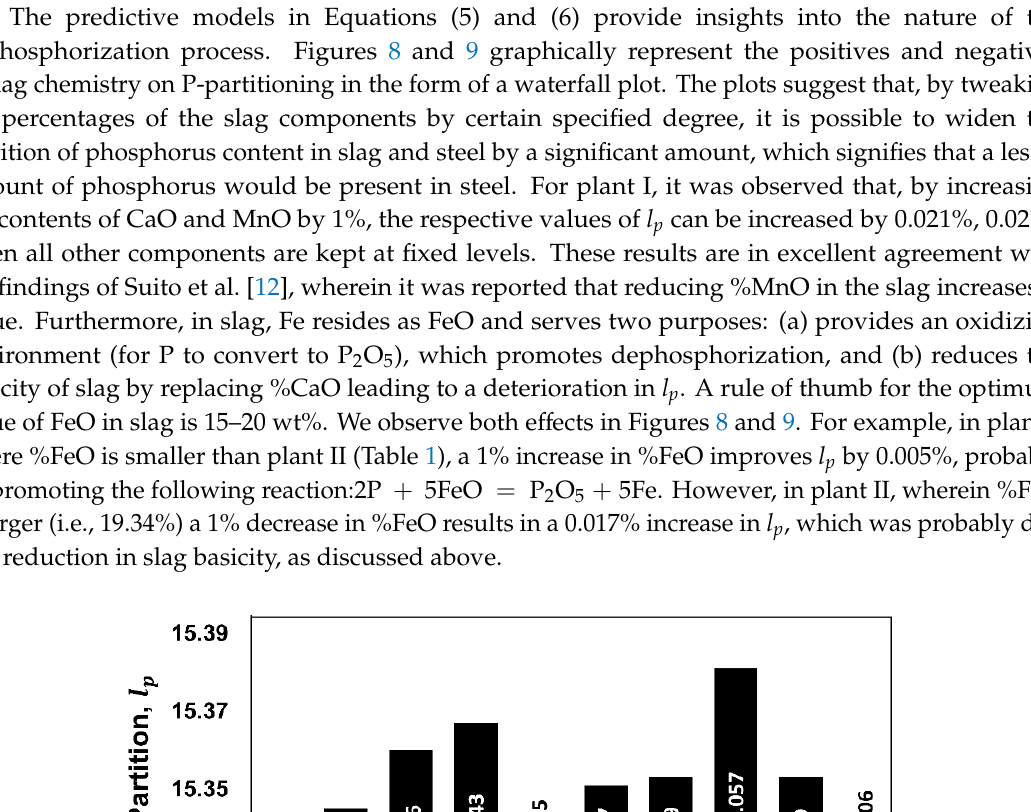
Figure 9. A waterfall analysis of the components in predicting phosphorus partition for plant II.